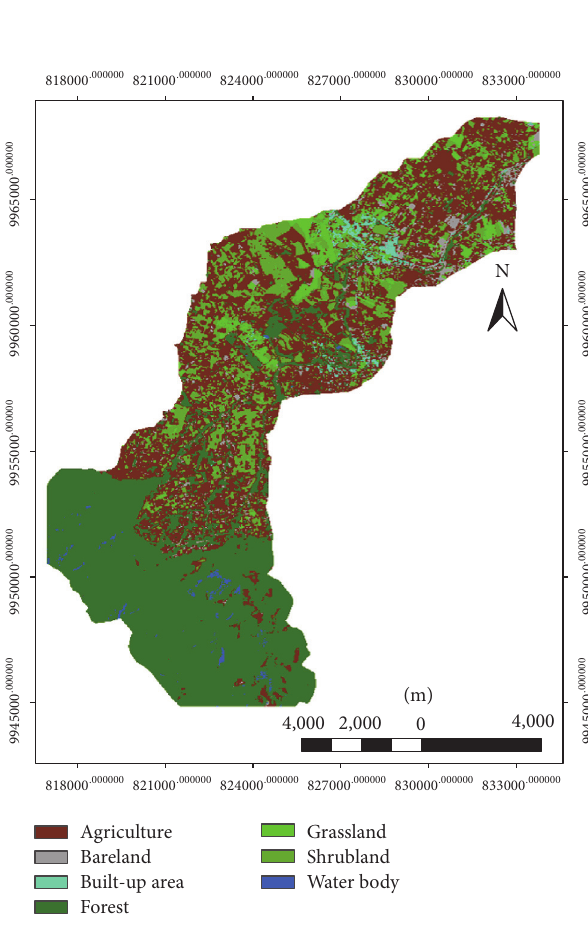
Figure 2: Land use map.